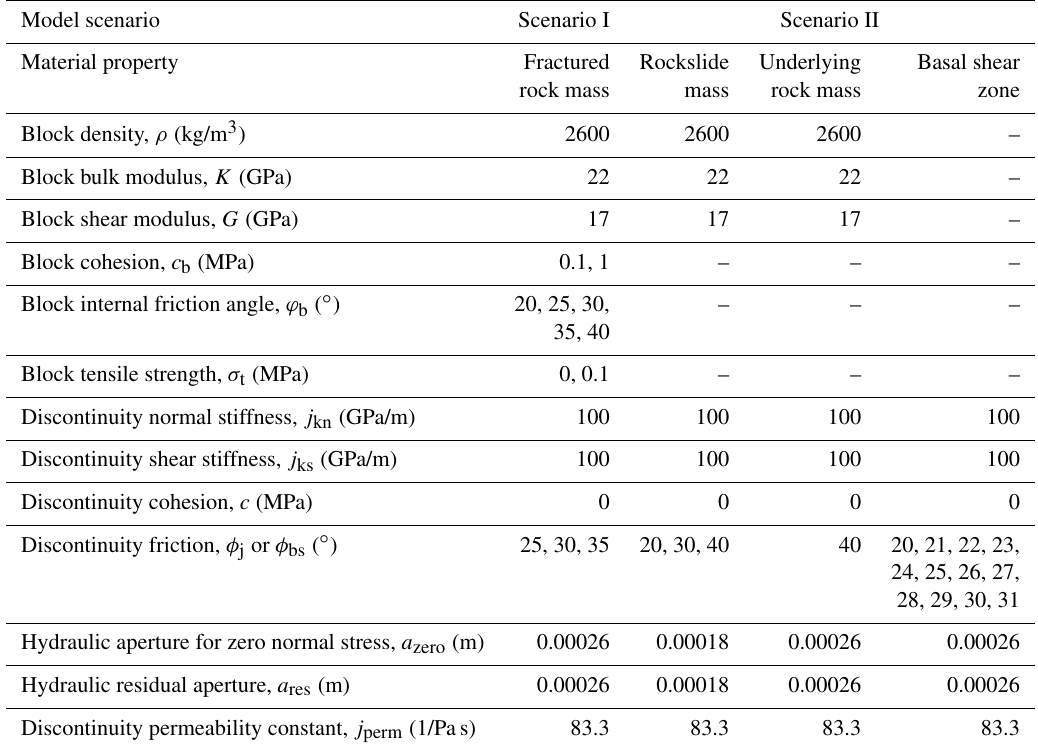
Table 1. Rock block and discontinuity properties for the distinct element modelling study for scenarios I and II, categorized into rockslide mass, underlying rock mass, basal shear zone and fractured rock mass. Hydraulic parameters ( a zero , a res and j perm ) are only relevant for model runs considering groundwater flow. Modelling scenario II is based solely on an elastic constitutive relationship for blocks, whereas for scenario I the blocks are simulated by applying a Mohr–Coulomb constitutive